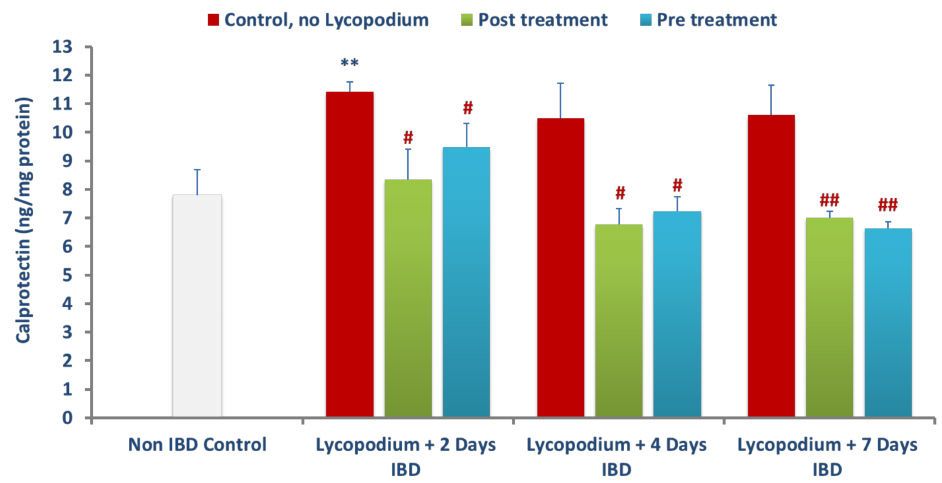
Figure 6. Effect of lycopodium on calprotectin levels in acetic acid-induced IBD in rats. Results are mean ± SEM. ** p < 0.01 vs. non IBD control group; # p < 0.05, ## p < 0.01, vs. relative IBD control